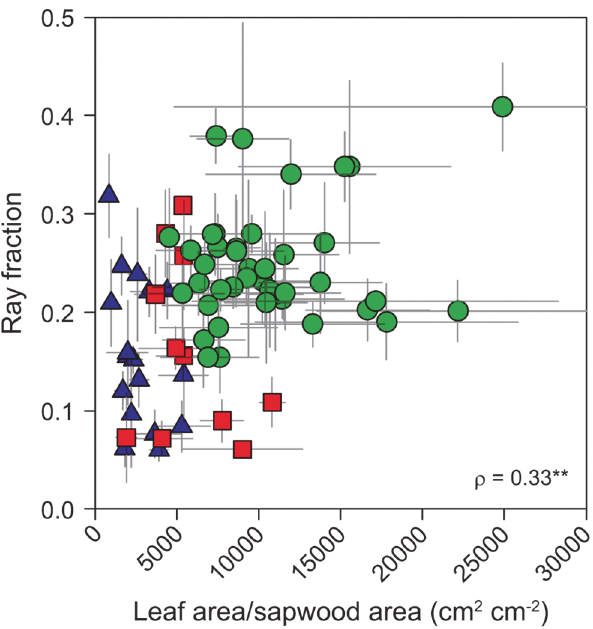
Fig 6. Relationship between ray fraction and leaf area to sapwood area ratio. Green circles — tropical rainforest (warm and wet site); red squares — tropical woodland (warm and dry site); blue triangles — temperate forest (cool and wet site). ** P < 0.01.